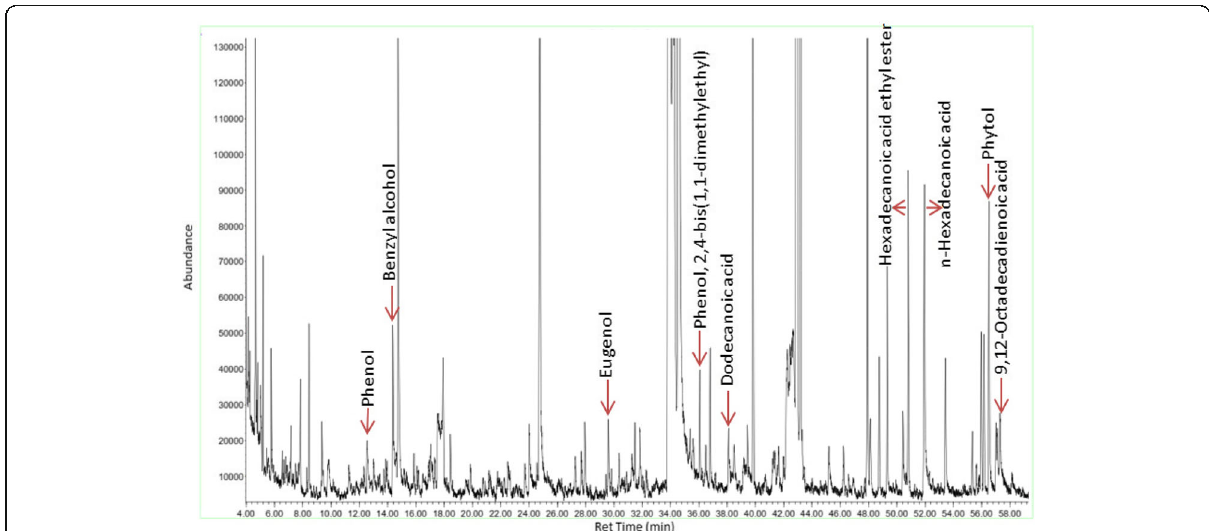
Fig. 2 GCMS chromatogram of the methanol extract of C.